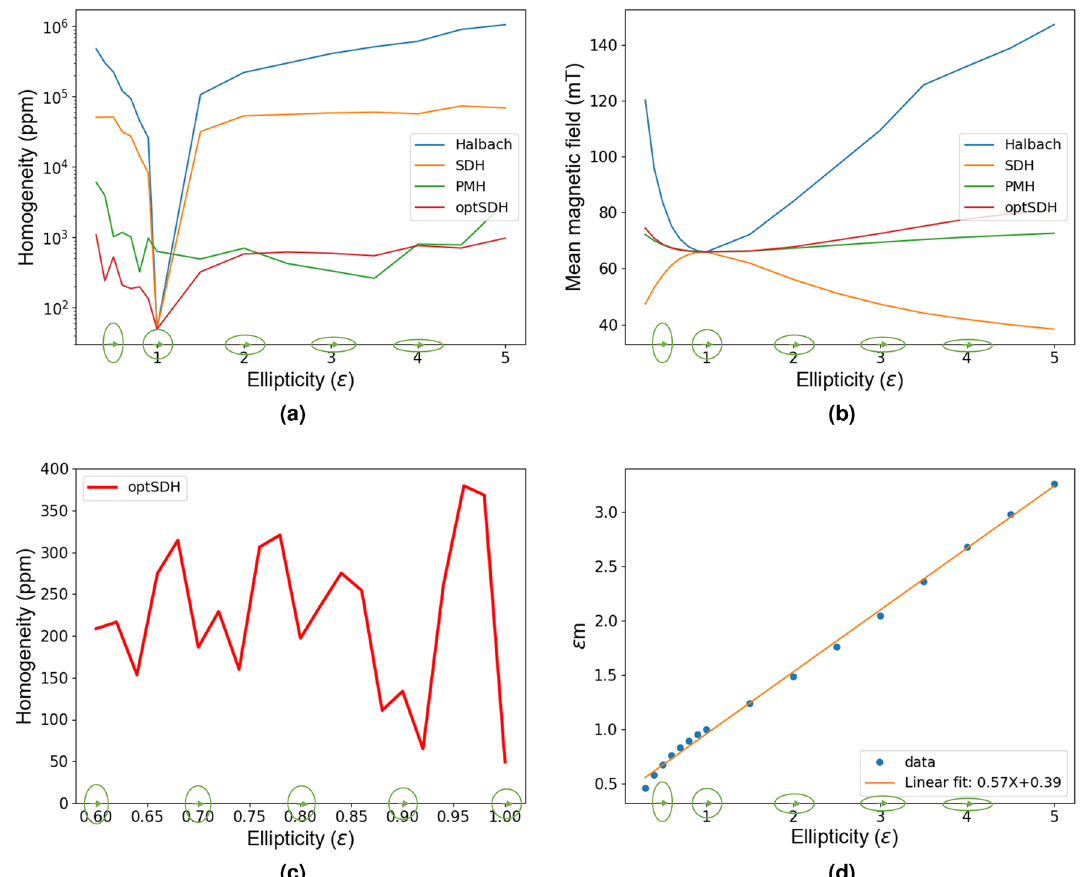
Figure 4. ( a ) Variation in homogeneity with ellipticity for the Halbach (blue curve), SDH (orange), optimized SDH (green) and PMH (red) rotation rules are shown in the same plot. The homogeneity of the field is measured in an elliptical ROI of the same ellipticity as the magnet. These values are plotted on a logarithmic scale. The green ellipses in the bottom show the different elliptic magnet designs corresponding to the ellipticity values along with the direction of the main magnetic field component. ( b ) Mean magnetic field as a function of ellipticity. Here it can be seen that if the target application demands the highest magnetic flux then Halbach rotation rules gives better results. ( c ) This represents a similar inhomogeneity variation plot as ( a ) for the optimized SDH rotation rule but taken at finer steps (0.02) along the ellipticity axis. ( d ) The inverse variation